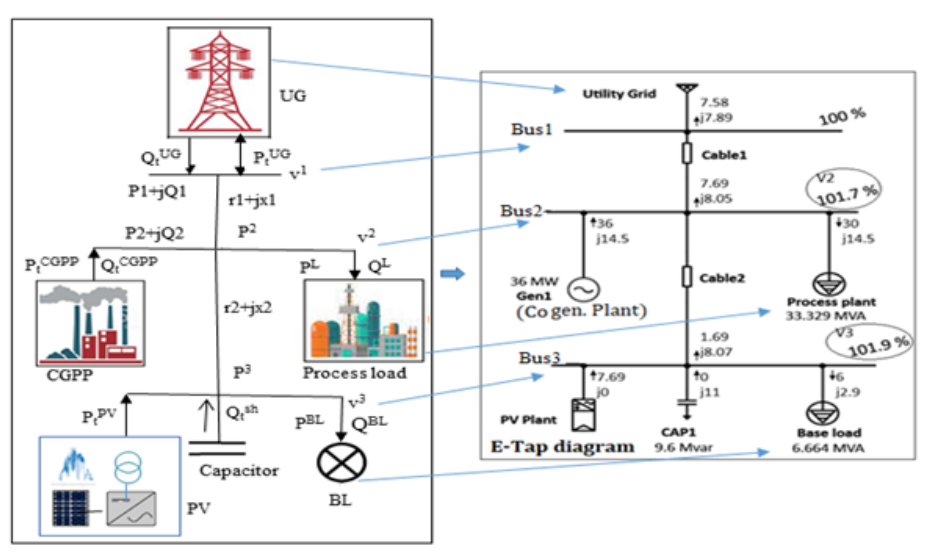
Figure 9. OLV of the industry ( left ) and load flow result with E-Tap ( right ). Table 11. Hourly step voltage or voltage ramp in kV for FA.